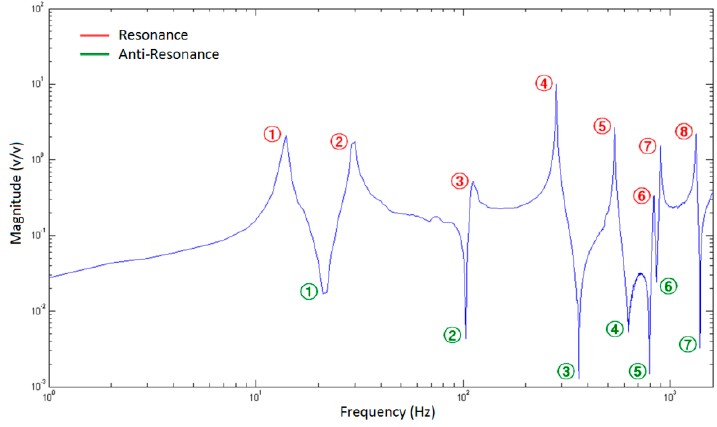
Figure 12. Frequency response function of the structural model to be identified.